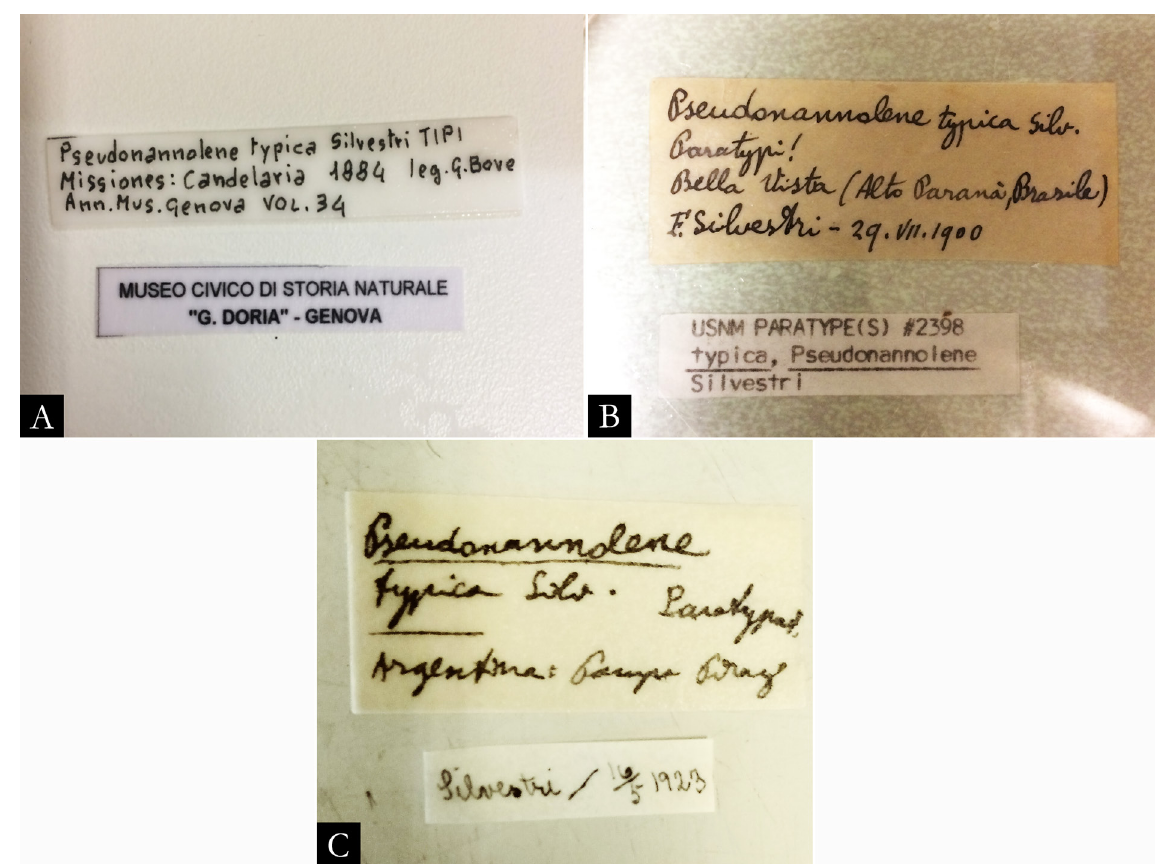
Fig. 138. Pseudonannolene typica Silvestri, 1895, holotype, ♂ (MCSN) and paratypes (USNM). A–C . Original labels of type material. Images not to